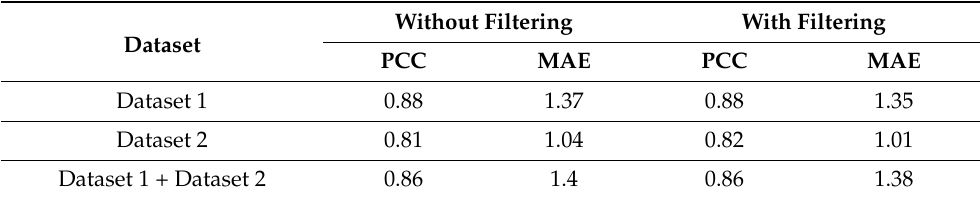
Table 5. Average mean absolute error (MAE), interpretable in breaths per minute, and Pearson’s correlation coefficient (PCC) achieved with and without motion artifact removal and signal quality assessment procedure (Section 4.1.2). The results are achieved using leave-one-subject-out (LOSO) cross-validation, on three dataset